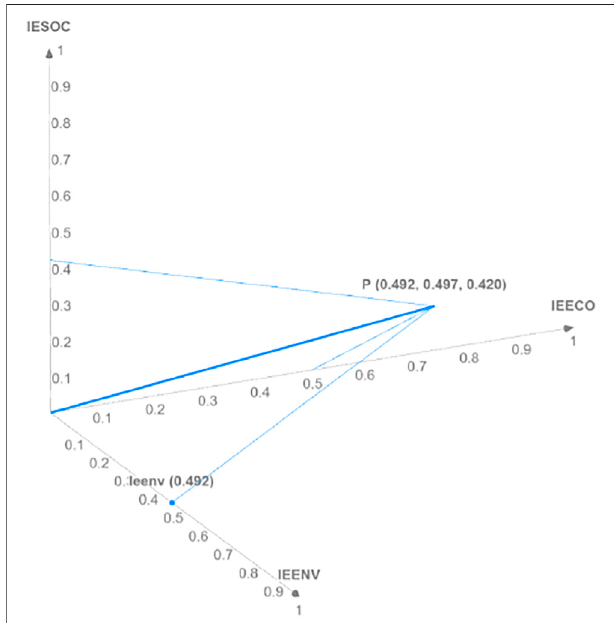
FIGURE 3 | Energy sustainable performance evaluation — authors ’ indicator p .